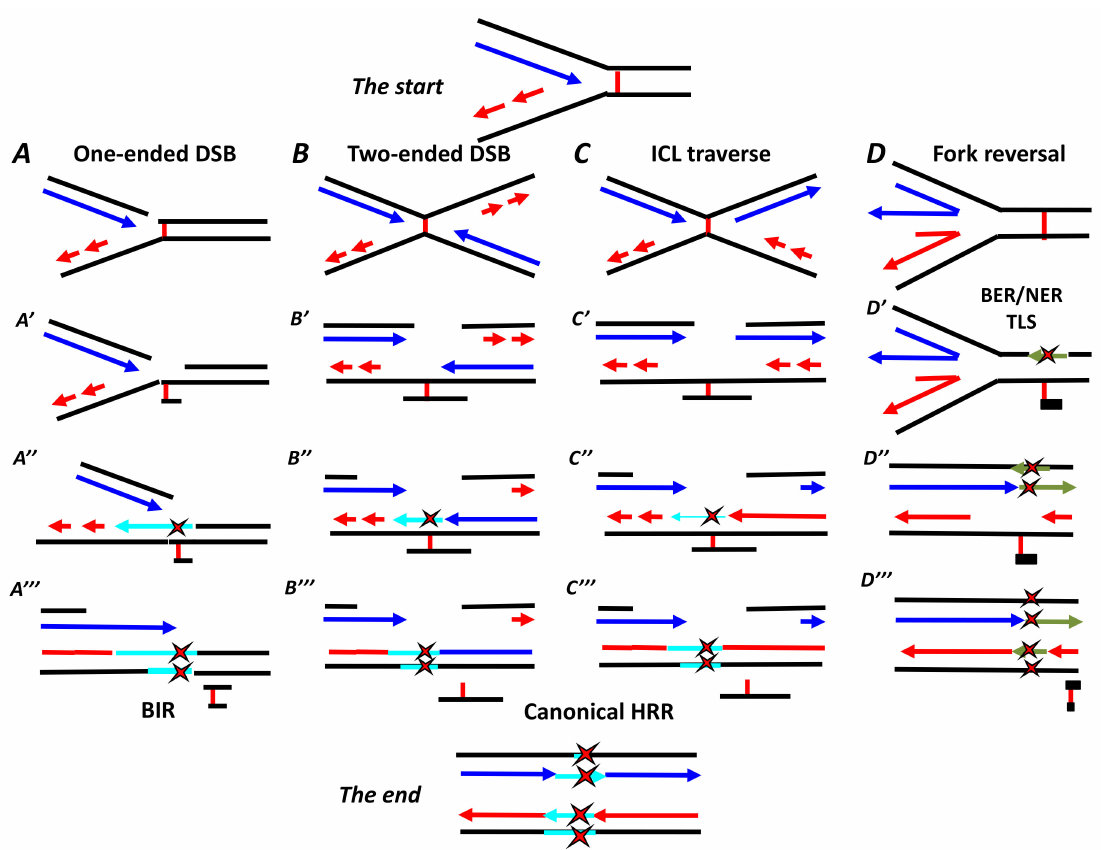
Figure 3. Models of interstrand cross-link (ICL) repair. (A ) A moving replication fork meets an ICL and stalls. Therefore, by cutting the DNA on one strand, a one-ended double-strand break (DSB) is formed. The ICL is unhooked, forming an ssDNA patch with the ICL on the strand opposite to the DSB (A (cid:48) ). Replication restarts with a possible insertion of an incorrect base in front of the ICL (A (cid:48)(cid:48) . After DSB resection, replication resumes from the other sister chromatid using BIR and the repaired chromatid as a template leading, in the end, after the ICL is completely unhooked, to an eventual a mutation on both sister chromatids (A (cid:48)(cid:48)(cid:48) ); ( B ) A stalled fork is stabilized until the arrival, from the other side of the ICL, another, convergent fork. Subsequently, at both stalled forks, a one-ended DSB is created, similar to a canonical two-ended DSB, but separated by a 30–40 nucleotide gap that will be rescued by homologous recombination repair (HRR) after the reconstruction of the opposite strand; ( C ) When the replication fork encounters an ICL, the replisome can traverse the lesion without repairing it to continue DNA replication. Later, the ICL will be unhooked (C (cid:48) ), eventually creating, as described above, a one- or two-ended DSB that will be repaired by HRR; ( D ) Alternatively, FANCM can stabilize and reverse the fork(s), allowing time for ICL unhooking before reestablishment of the fork and the “traverse” of the lesion. As in A and B, the repair and replication rescue mediated by pathways C and D lead to the risk of generating and fixing mutations in the duplicated DNA. Red stars indicate the induction of possible mutations by translesional synthesis (TLS)